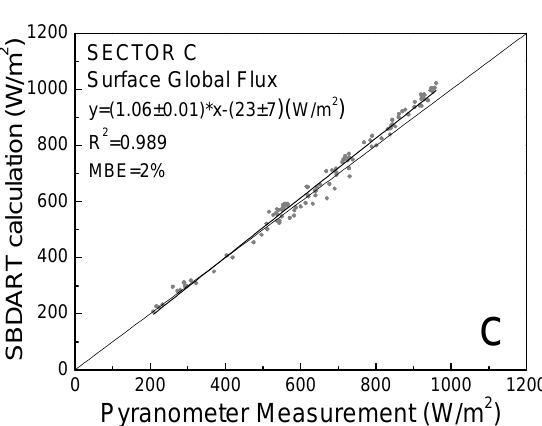
measured and modeled values were well correlated in the three dust origin classes. The statistical analysis gives